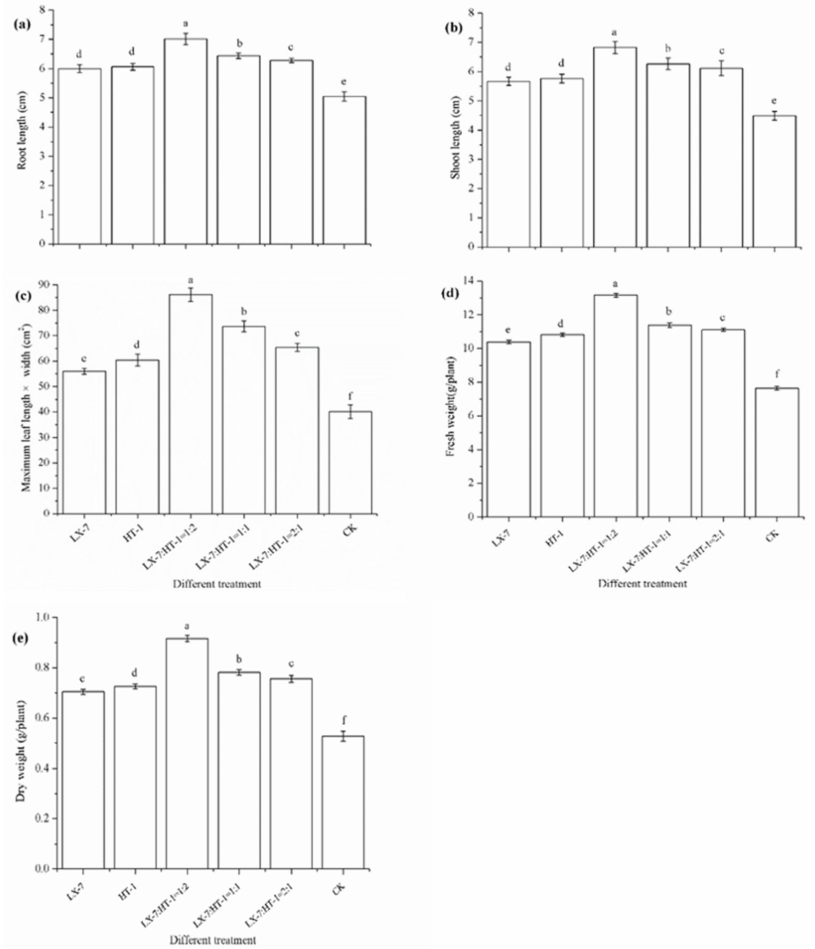
Figure 5. Effects of HT-1 and LX-7 strains on root length ( a ), shoot length ( b ), maximum leaf length × width ( c ), fresh weight ( d ) and dry weight ( e ) of Brassica chinensis L. plants. Values are mean ± SD (n = 15 plants). Different letters above the bars indicate the differences are significant at p <